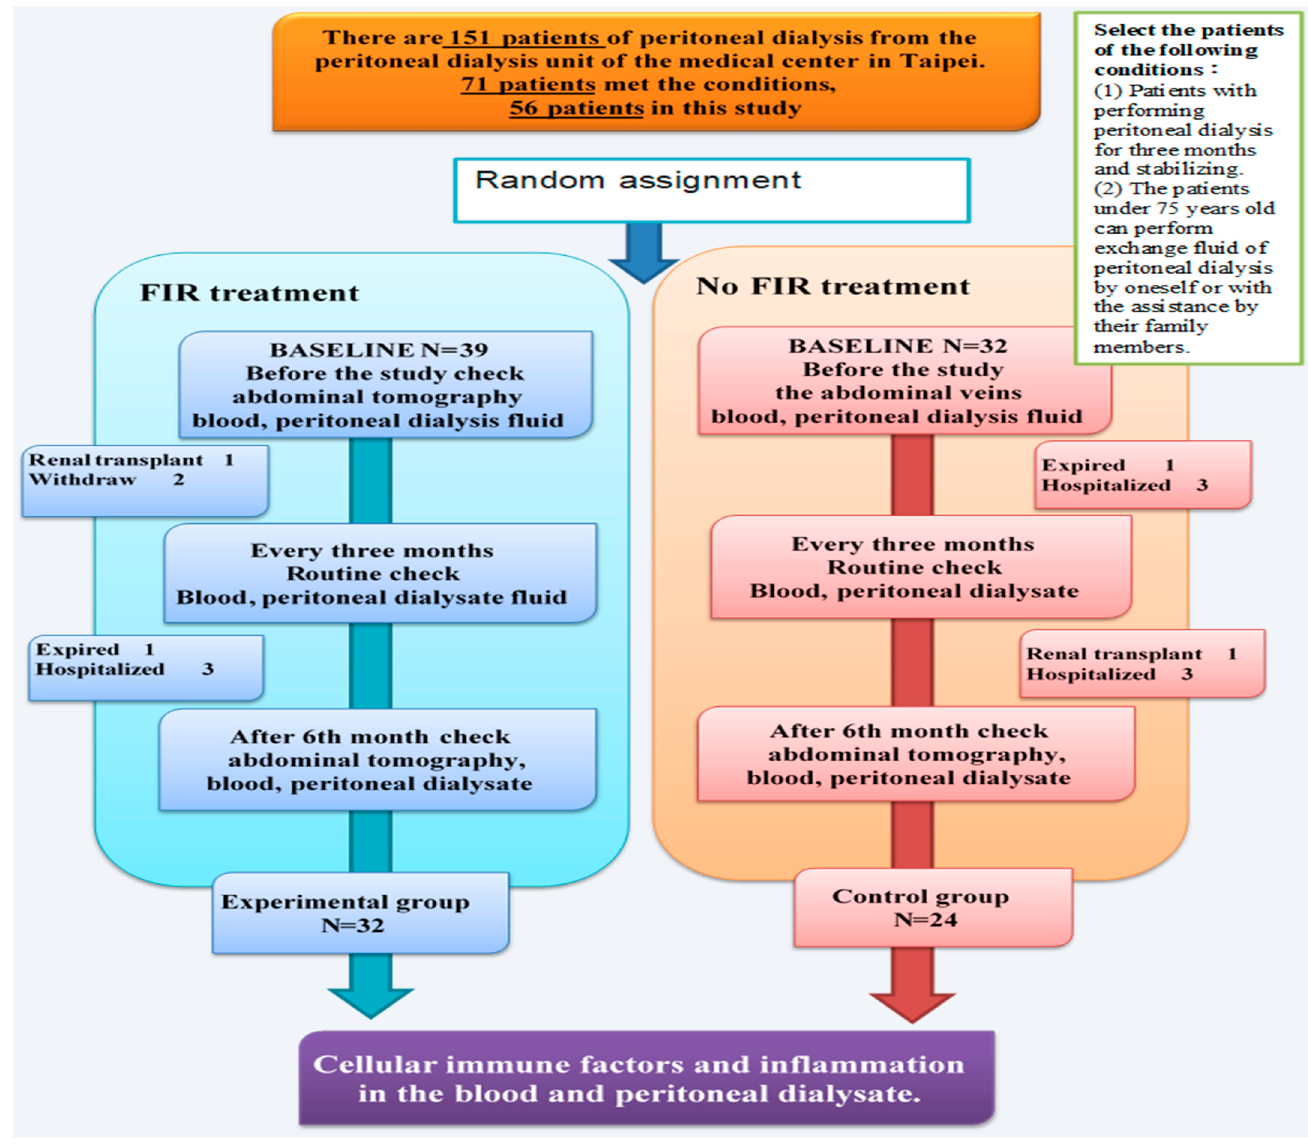
Figure 1. Flow chart of participants comparing the effect of patients undergoing FIR treatment and non-FIR treatment.